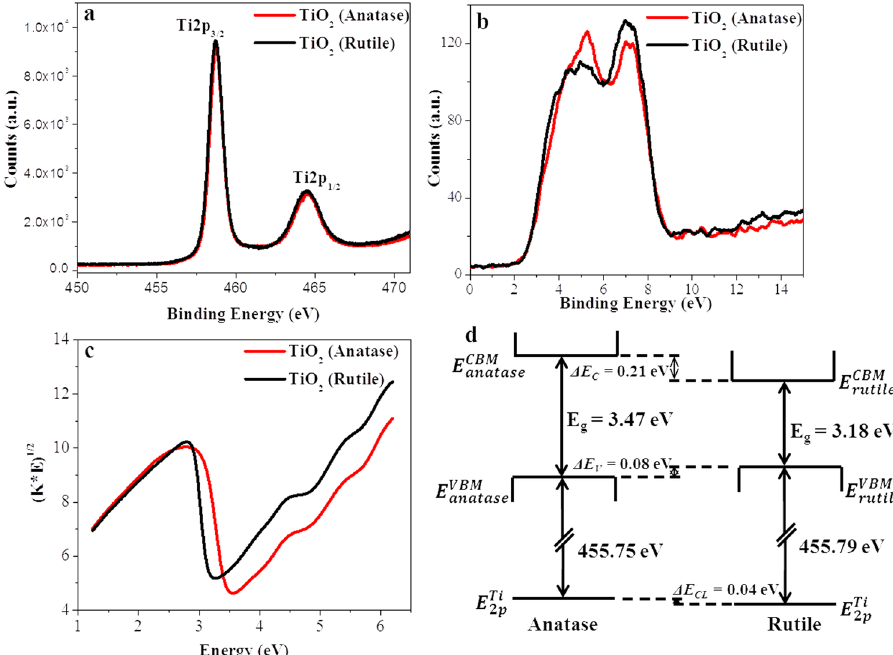
Figure 4. ( a ) The core level photoelectron spectra of Ti(2 p ), ( b ) valance band regions, ( c ) Tauc plot, and ( d ) schematic of XPS alignment with band gap obtained from Tauc plot of anatase and rutile TiO 2 . Δ E V and Δ E C are the valance band offsets and conduction band offsets, respectively and Δ E CL core level offset between the Ti(2p 3/2 ) core levels. E VBM and E CBM are the positions of the valance and conduction band, respectively and Eg is band gap obtained from Tauc plot.